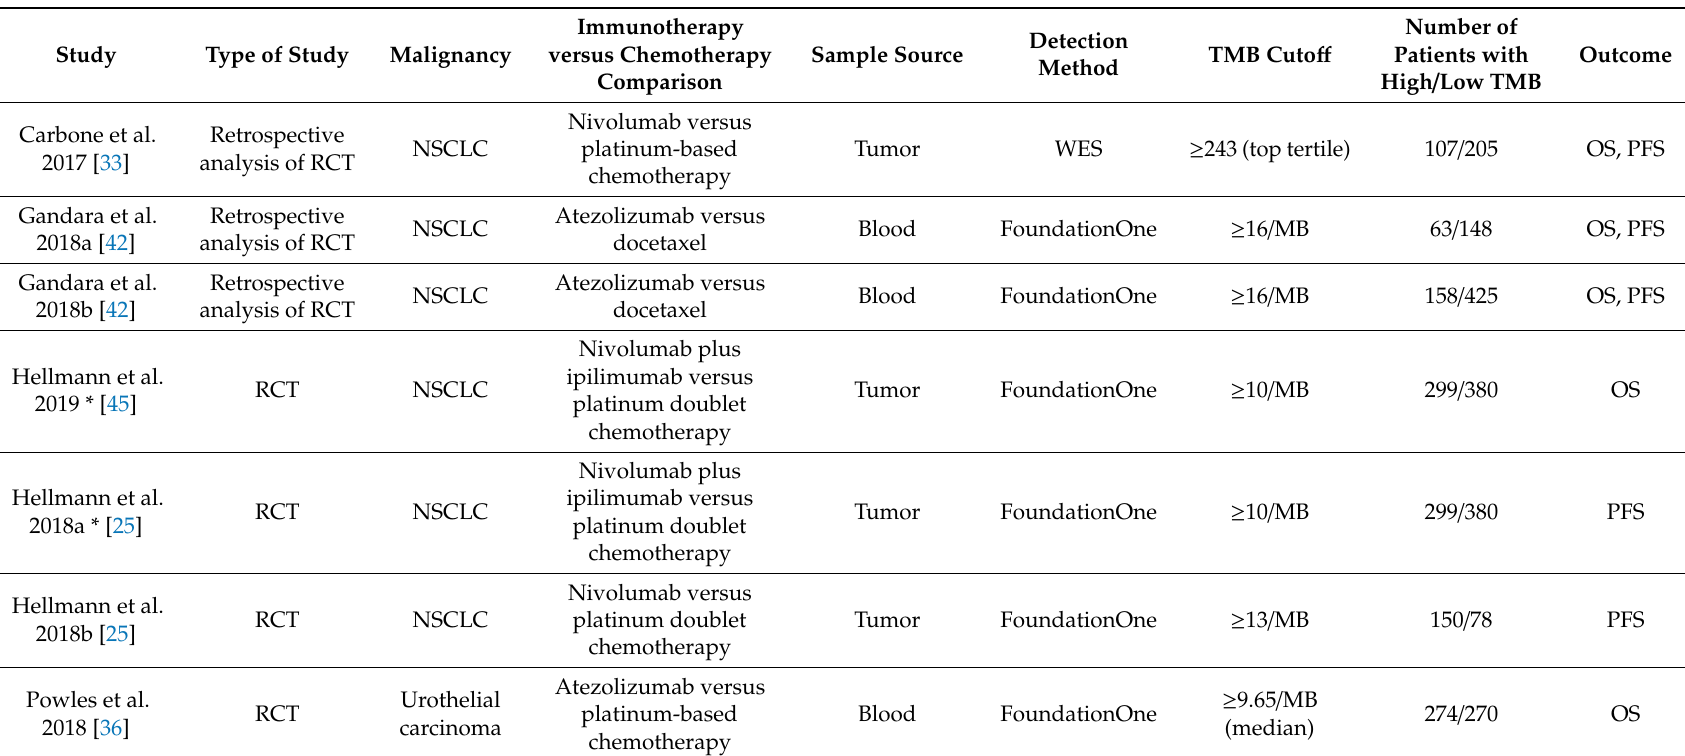
Table 2. Characteristics of studies included in the meta-analysis of the immunotherapy group versus chemotherapy